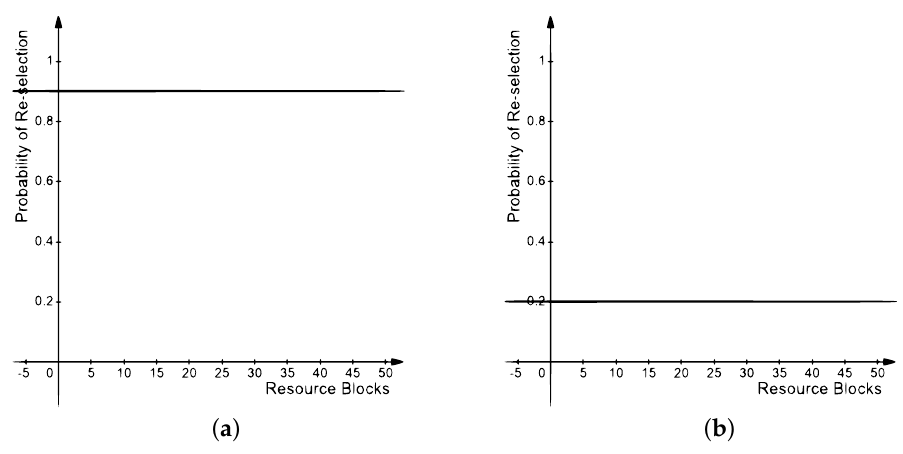
Figure 11. Probabilities of reselection; ( a ) For R x = 5, ( b ) For R x = 40. In Lines 6–7, if a vehicle has a beacon to transmit, it first selects a suitable RB. The al- gorithm uses a 64 bit crypto-hash function, which is pruned and mapped to an RB number. From Line 8 to Line 10, to avoid resource collision with neighbors, each vehicle tries to predict the RB selection by its neighbors. For each of its neighbors, a vehicle uses a seed that includes the MAC address of a neighbor and t l to acquire a list of all the RBs selected by its neighbors. In Line 12 and Line 13, if the vehicle finds resource collision, then the vehicle selects an RB that has the least SNR value across all the RBs. From Lines 15–17, the process of counter selection is called. The value of the counter is determined via Line 22–25. If the value of β is less than 35%, then the standard value of counter S c (Std) is used, which is [5–15]; otherwise, Equation (9) is used to set up the counter value. At Line 27, transmission is performed on the selected RB. RB reselection is carried out in Lines 30–34 when the counter value reaches zero. If the same RB is reassigned, transmission is established; otherwise, the process of acquiring a new RB is restarted via RB